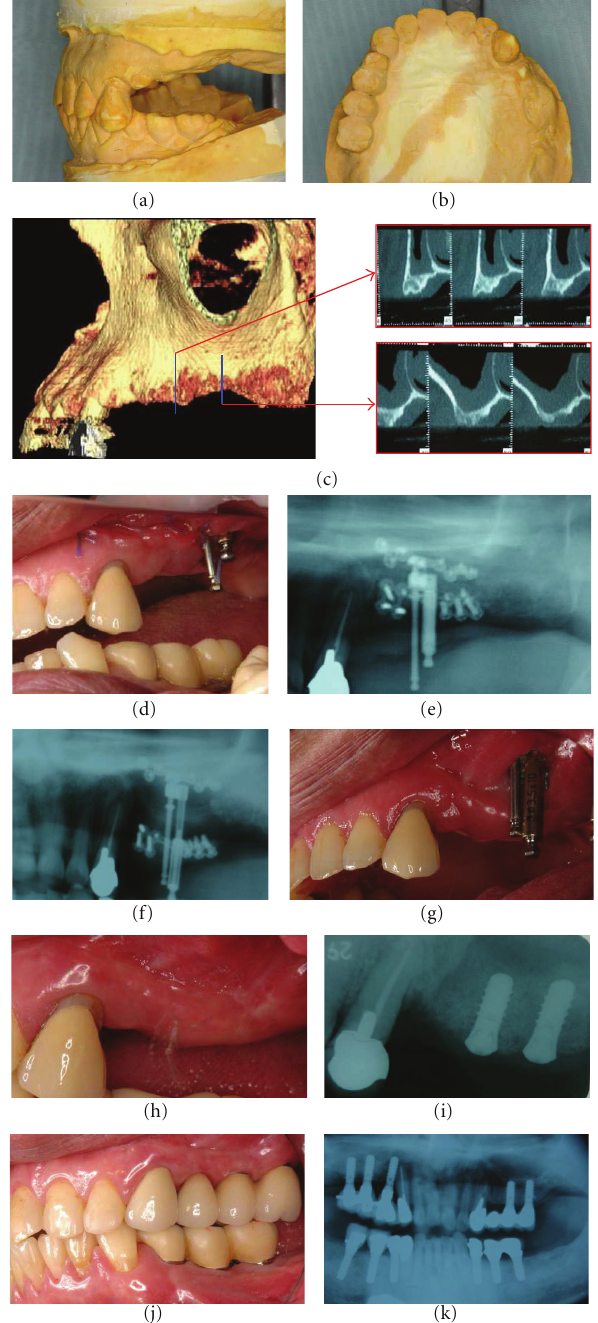
Figure 3: Representative case of unilateral sinus lifting and simultaneous unilateral alveolar distraction for a unilateral partially edentulous, severely atrophic posterior maxilla (Case 5, Table 2). (a, b) Preoperative plaster models of the left posterior maxillary atrophy; (c) preoperative CT views; (d) postoperative intraoral view; (e) postoperative X-ray before activation of distraction with unilateral sinus lifting and simultaneous alveolar distractor setting; (f) postoperative panoramic X-ray after the end of distraction; (g) after the end of vertical distraction; (h) at the time of implant placement and 3 weeks after distractor removal for soft tissue healing; (i) dental X-ray after implant placement; (j) the definite prosthesis was placed after 1 year of provisional restoration as the postloading period; (k) panoramic X-ray taken after 2